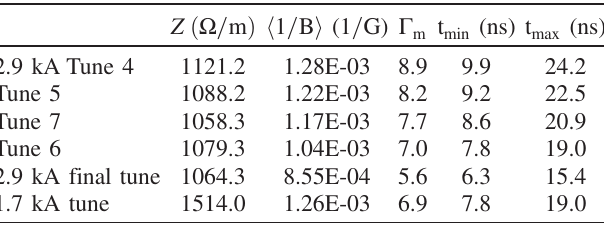
, and the minimum and m are also m